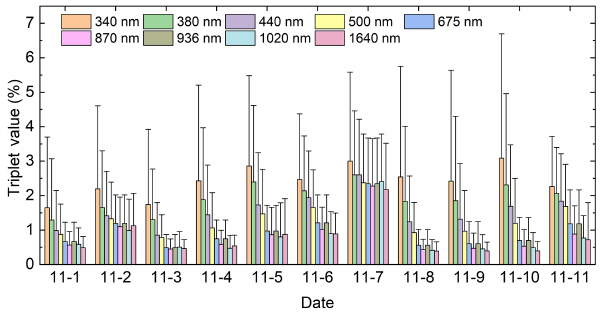
Figure 5. Daily triplet value at each wavelength on 11 case days from 1 Nov (“11-1”) to 11 Nov (“11-11”).